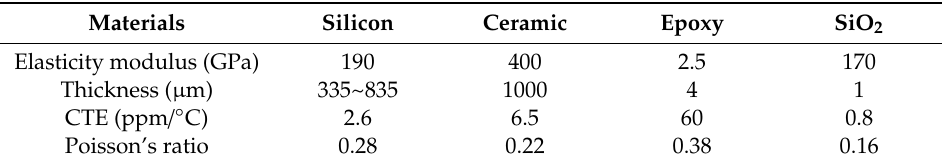
Table 1. Physical properties of various